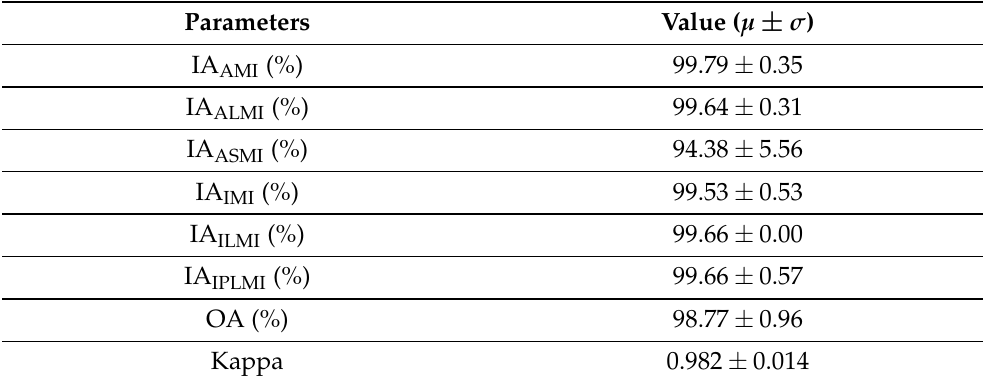
Table 7. Classification results obtained for MI localization using proposed MMDCNN model with hold-out validation.